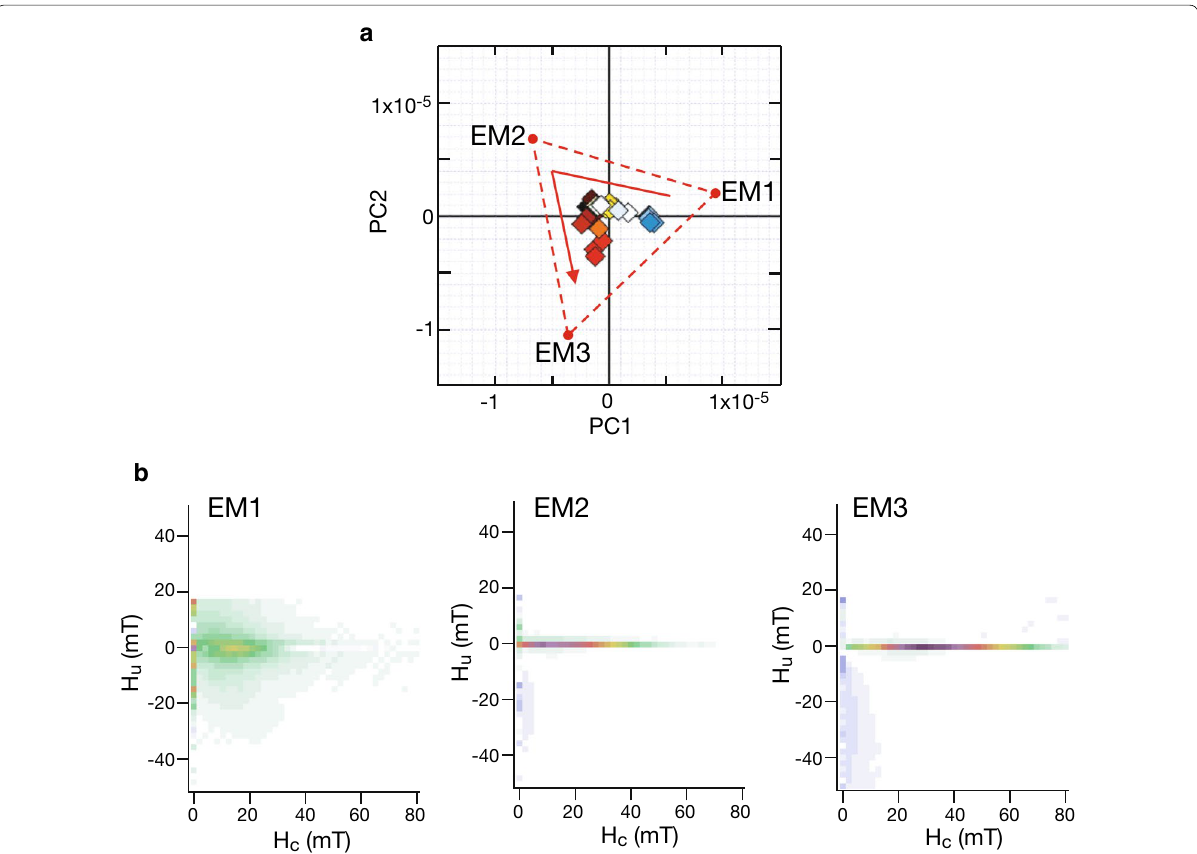
Fig. 4 Principal component analysis (PCA) of first-order reversal curve (FORC) diagrams for core KR13-02 PC06. a Distribution of 26 FORC data (squares) on the principal component PC1-PC2 plane. Triangular dashed lines define a three-endmember (EM) system, and the arrow indicates the general downcore trend. b FORC diagrams for EM1, EM2, and